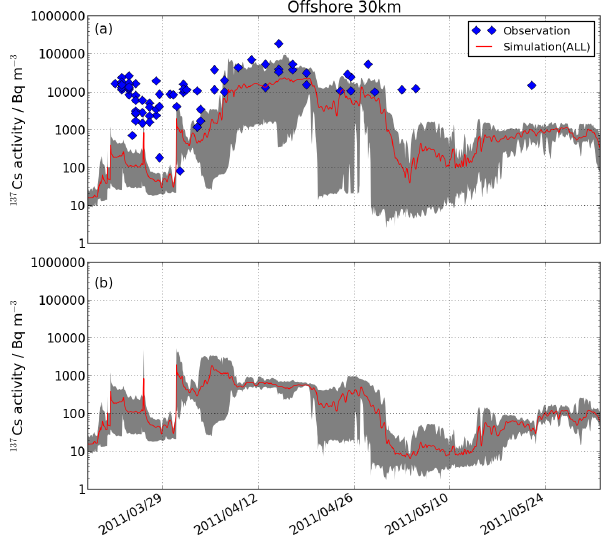
Fig. 7. (a) Measured 137 Cs activities (Bqm − 3 ) 30km offshore in the surface water at 1–8 stations (Supplement S-Fig. 1) and simu- lated 137 Cs activities at all sites (ALL scenario). Gray shading in- dicates the range of simulated activities at eight stations, and the red line shows the averaged simulated activities at eight sites. (b) Difference of activities between ALL and D RELEASE scenarios.